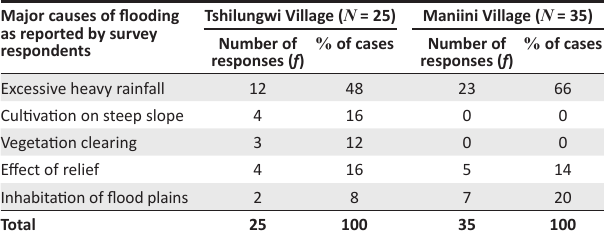
TABLE 1: Community perceptions on causes of the flood disaster in Tshilungwi and Maniini